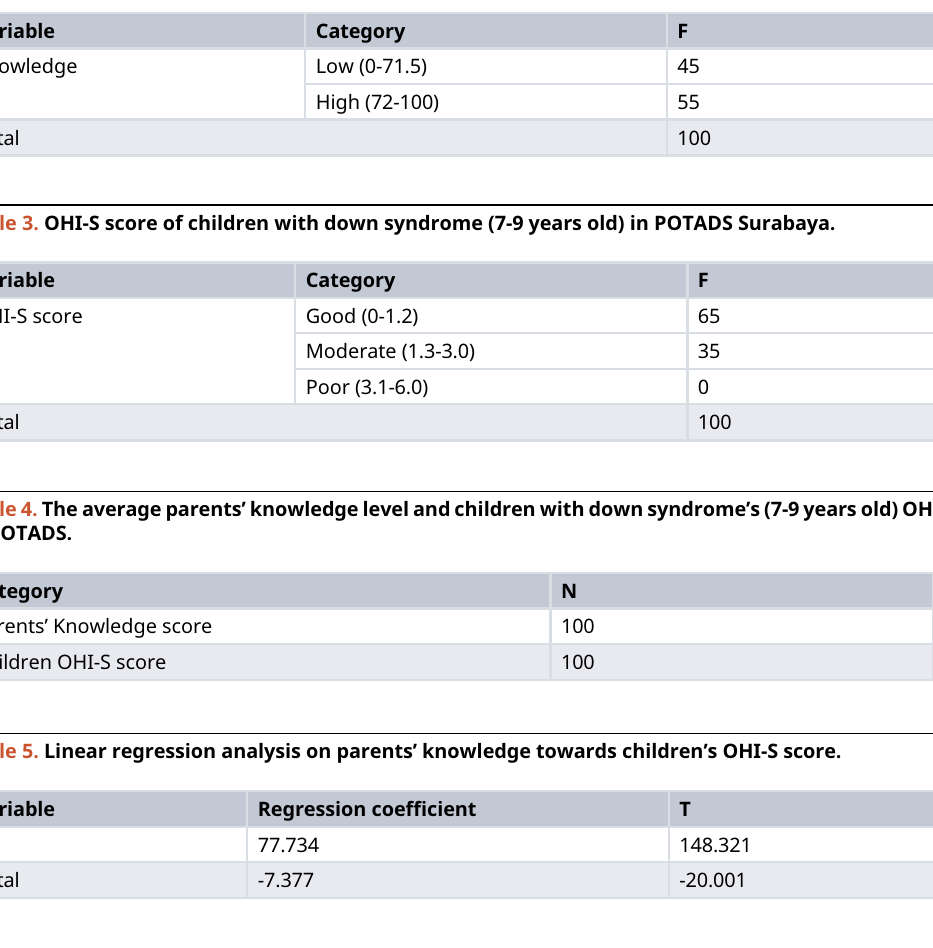
Table 2. Parents; knowledge in maintaining children ’ s oral hygiene frequency.